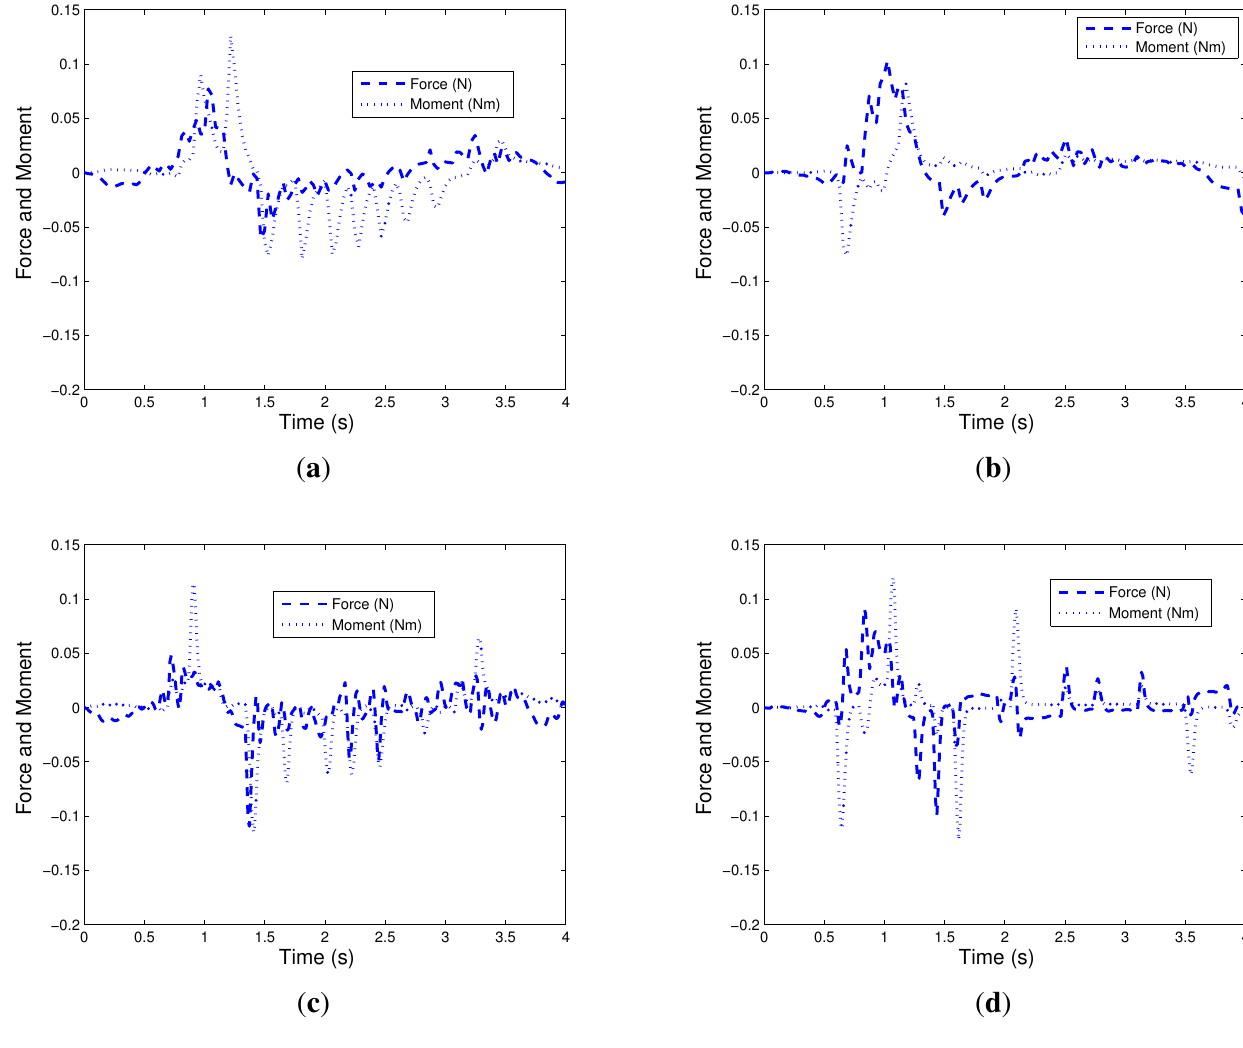
Figure 11. Force and Moment. ( a ) NN1; ( b ) NN2; ( c ) FS1; ( d ) FS2; ( e )